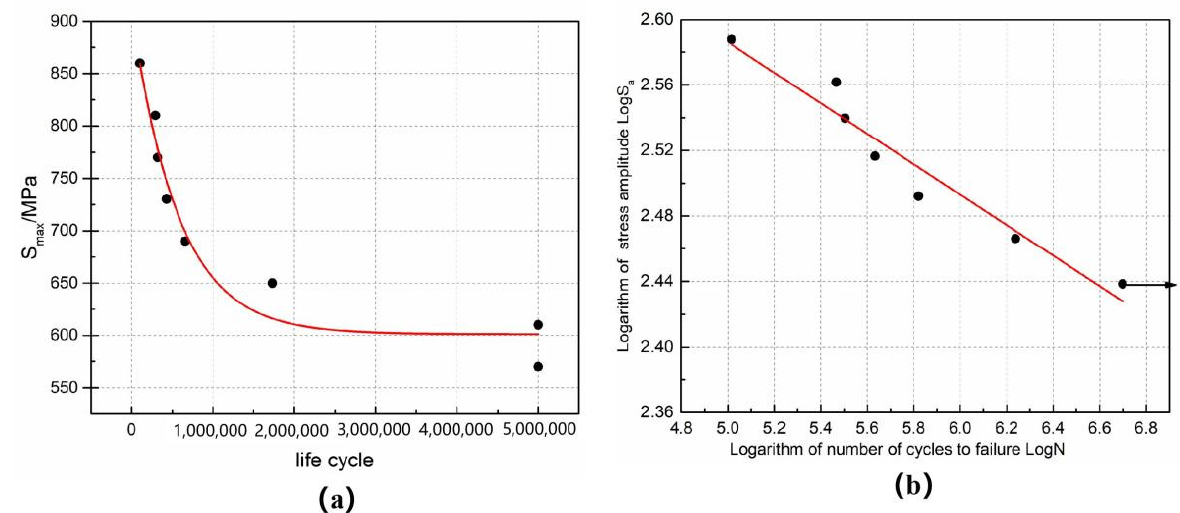
surfaces above the stripes. Figure 8e,f show the morphology of the instantaneous fracture zone. Under a high stress cyclic load, tire indentation appears, as can be seen in Figure 8e,f, dimple morphology appears. In this stage, the crack is in the high-speed propagation phase. Under the action of fatigue cyclic load, dimples of different sizes gradually gather and connect with each other, and finally form a dimple fracture. Combined with the above characteristics, the fracture is a mix of cleavage fracture and ductile fracture.